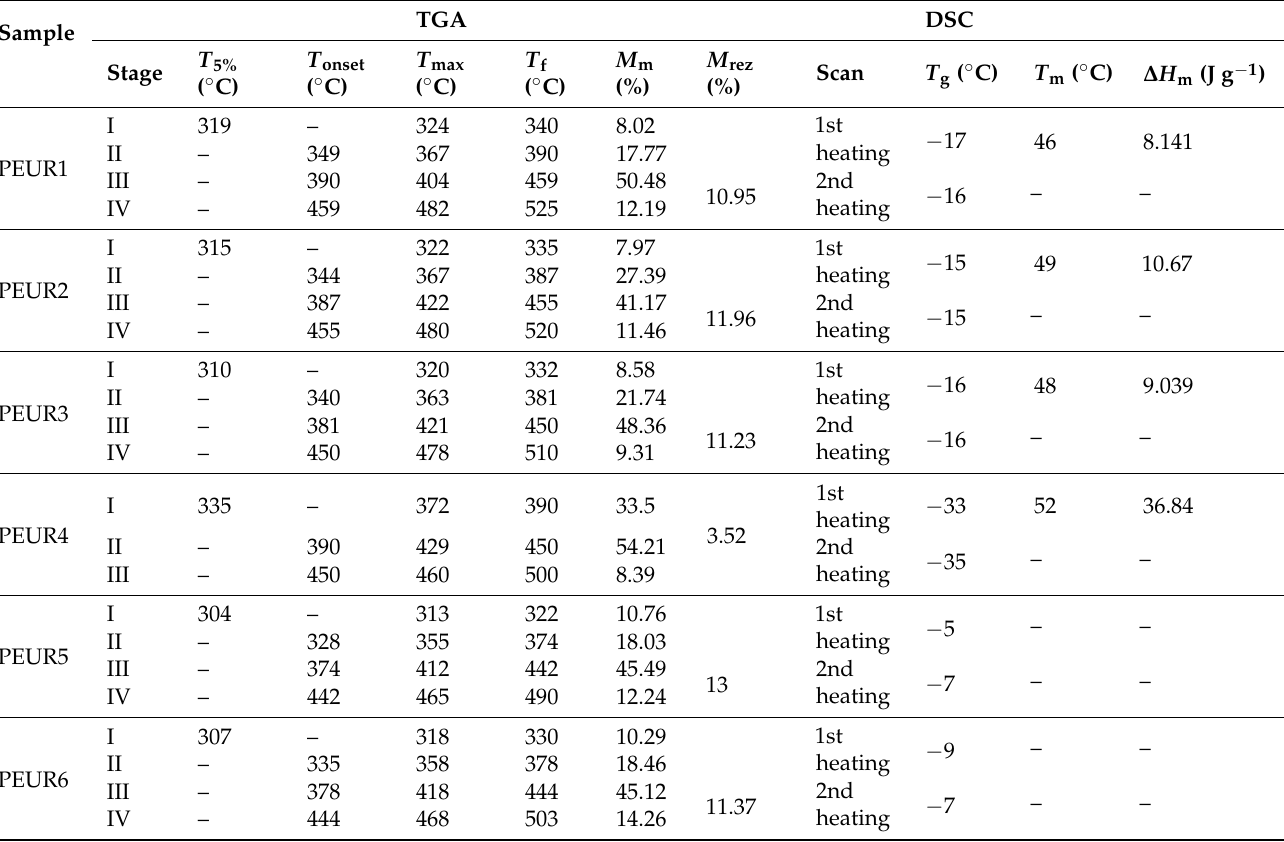
Table 4. Data extracted from TG, DTG and DSC